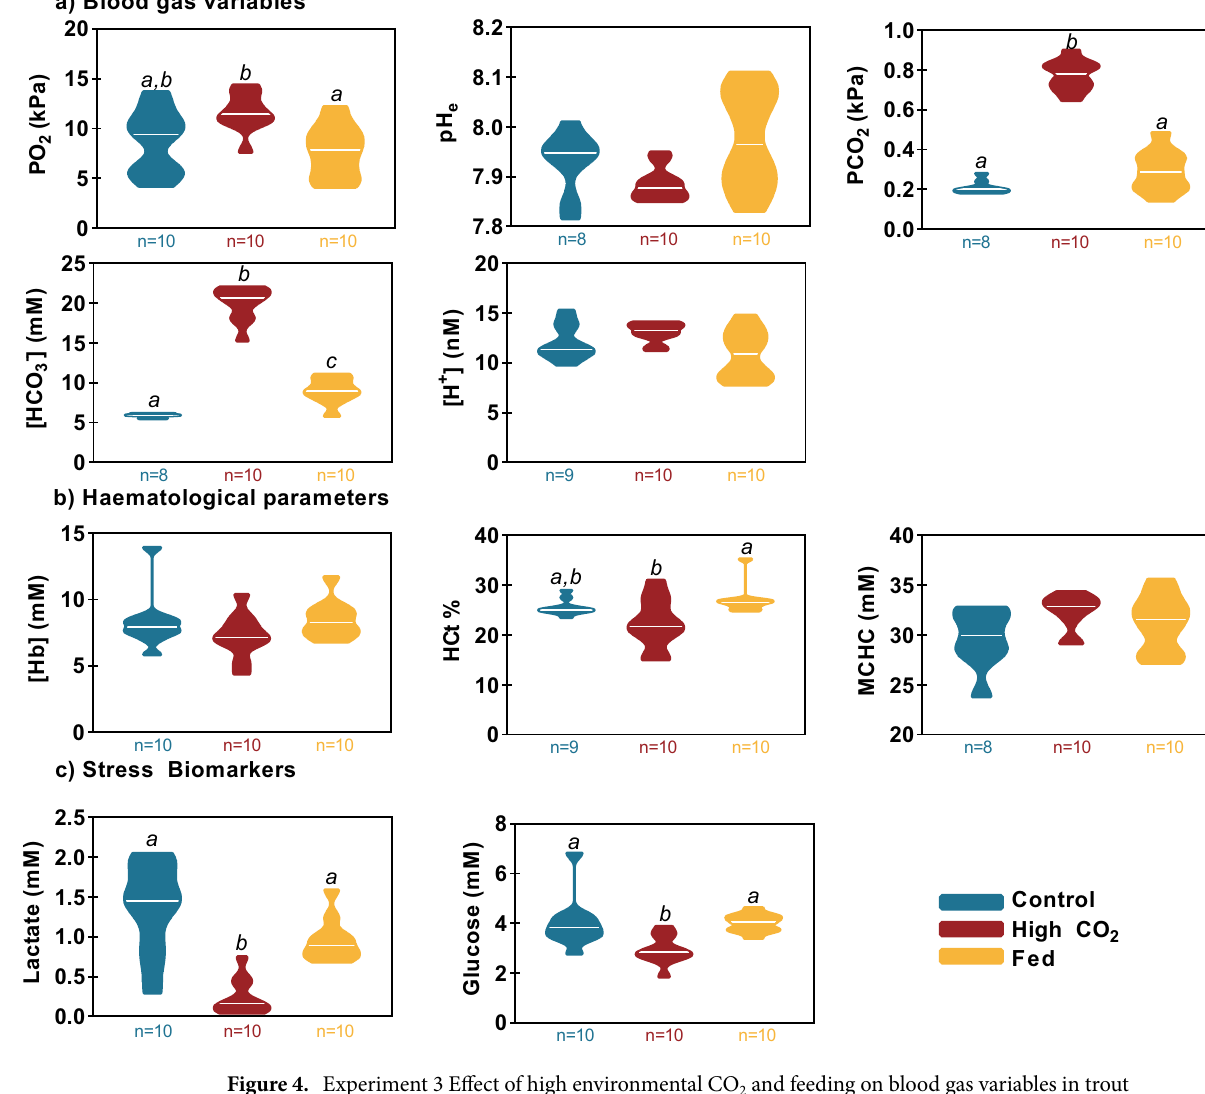
Figure 4. Experiment 3 Effect of high environmental CO 2 and feeding on blood gas variables in trout below cannulatable size. ( a ) Blood gas variables (blood PO 2 , blood pH e , blood pCO 2 , plasma bicarbonate concentration). ( b ) Haematological parameters (haemoglobin concentration, haematocrit, mean corpuscular haemoglobin concentration). ( c ) Stress biomarkers (lactate concentration, glucose concentration) Data presented as truncated violin plots with a solid white line denoting the median and dotted white lines indicating the bounds of the inter-quartile range (IQR). Significant differences are denoted by different letters as determined by ordinary one-way ANOVA with Tukey’s multiple comparisons and alpha defined as